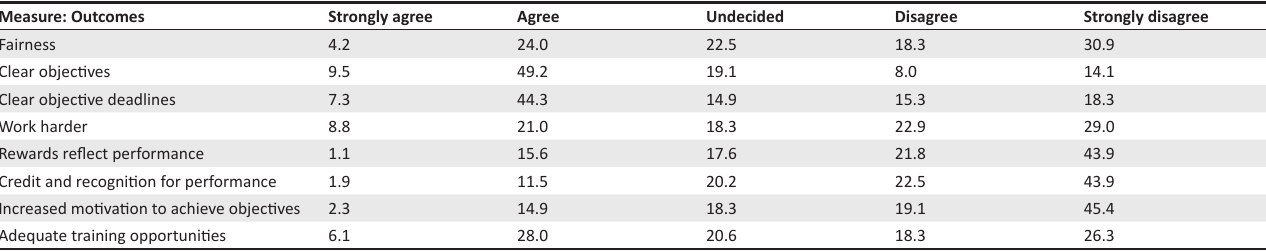
TABLE 5: Longer-term perceived outcomes of the performance management system (administrative staff). Measure: